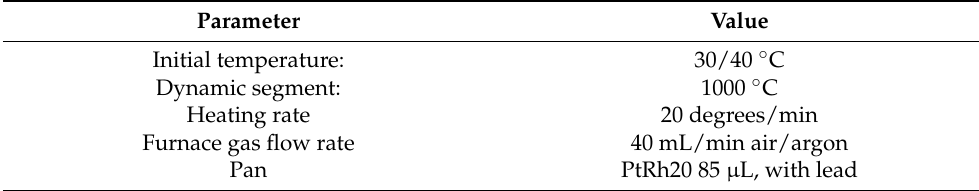
Table 1. Simultaneous thermal analysis conditions.